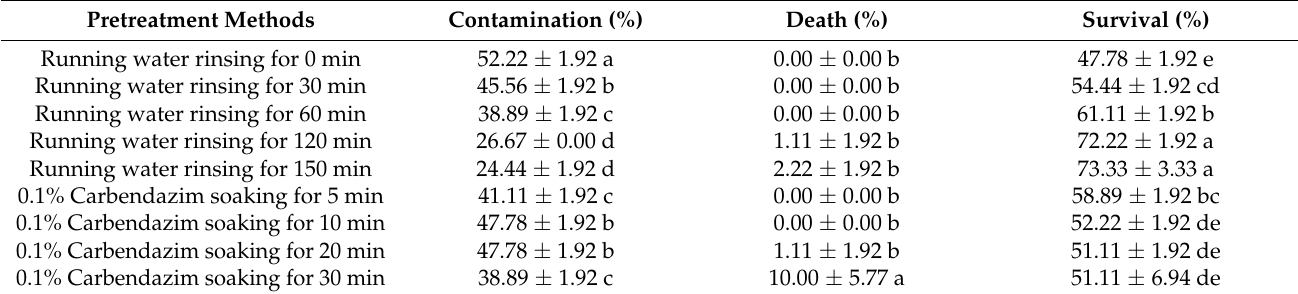
Table 3. Effect of different pretreatment methods on explant